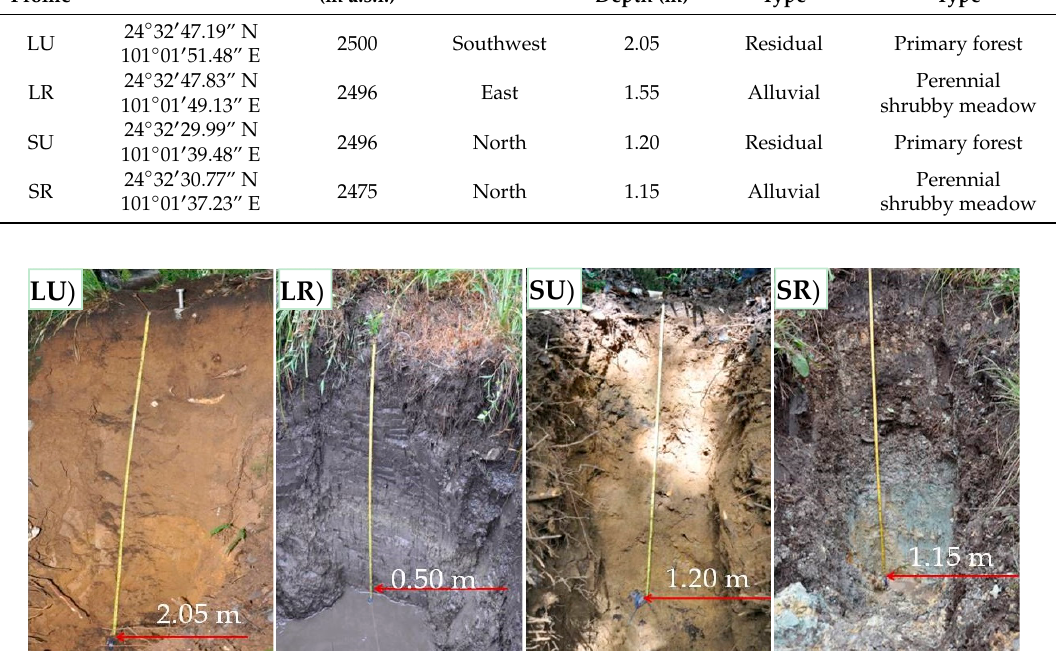
Figure 2. Photos of the four soil profiles (LU, LR, SU and SR) in a montane subtropical moist forest of southwestern China. Note the standing water table in LR and the grey color in SR.